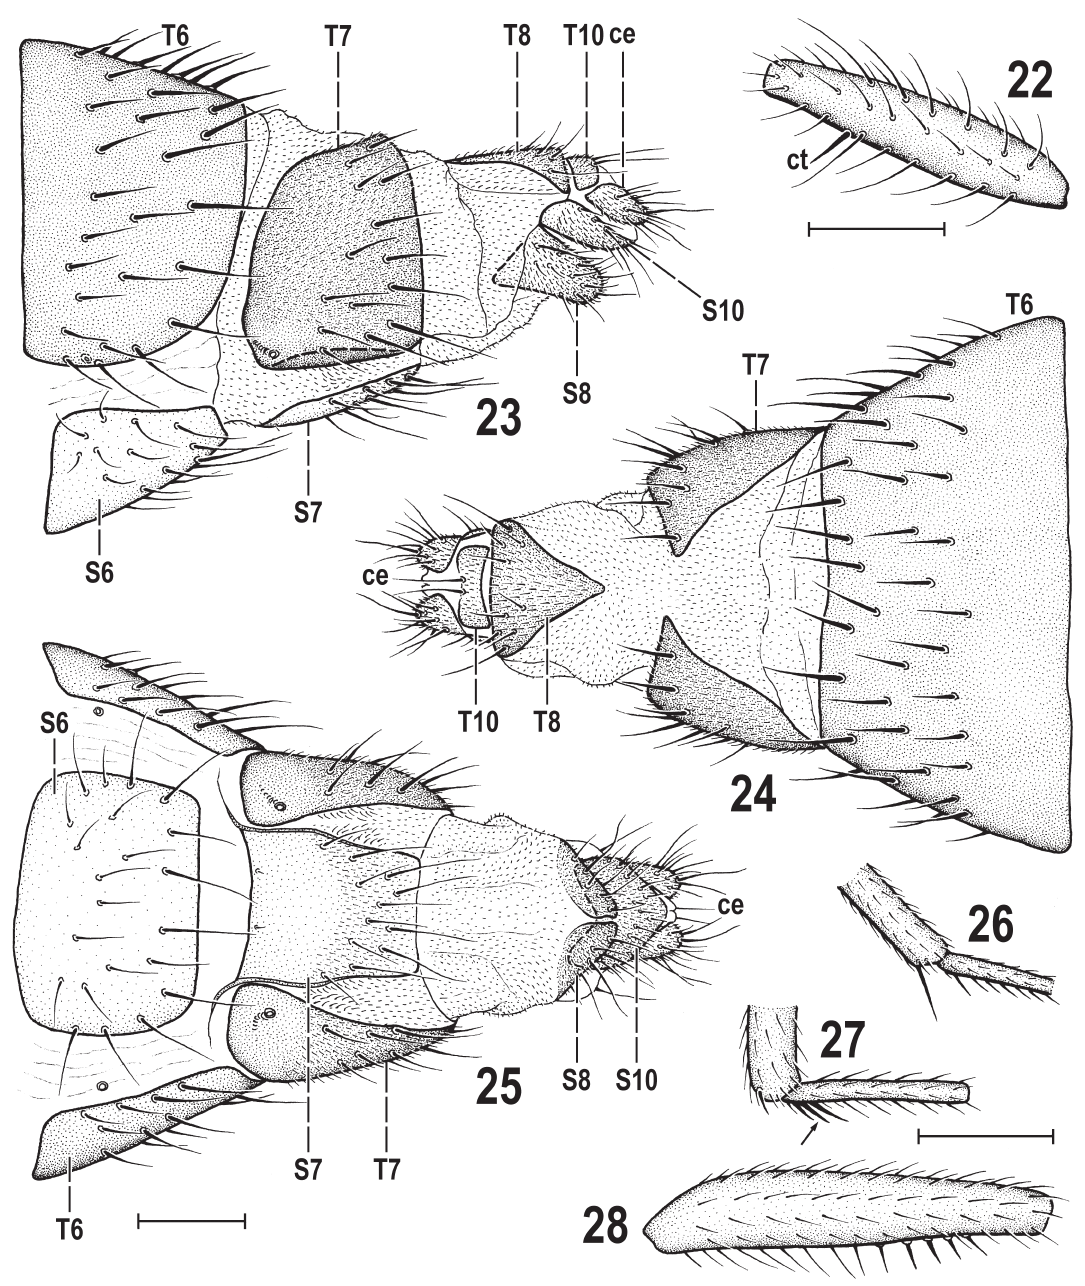
Figs 22–28. Mumetopia interfeles Roháček sp. nov., paratypes (SMOC MIT002–MIT006, MIT081– MIT083). 22 . ♂, f , posterior view. 23 . Female postabdomen, lateral view. 24 . Same, dorsal view. 1 and base of mid basitarsus, anterior view. 27 . Apex of male 25 . Same, ventral view. 26 . Apex of male t 2 t and hind basitarsus with 3 thickened ventrobasal setulae (black arrow), anterior view. 28 . Male f 3 anterior view. Scale bars: 22, 26–28 = 0.2 mm; 23–25 = 0.1 mm. For abbreviations see Material and